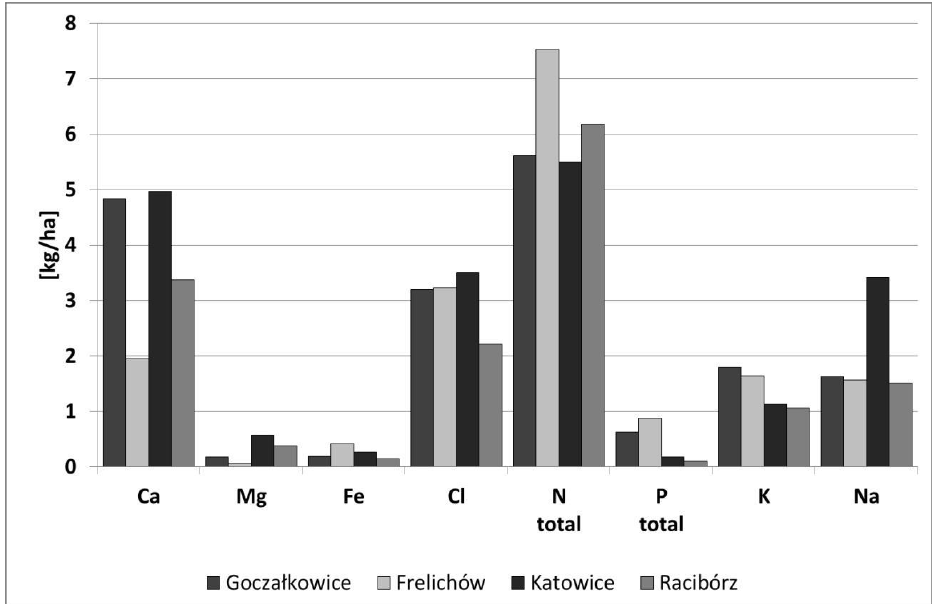
Fig. 7. Mean values of wet deposition in the summer season for Goczałkowice, Frelichów, Katowice and Racibórz between 2011-2012 [kg·ha -1 ]